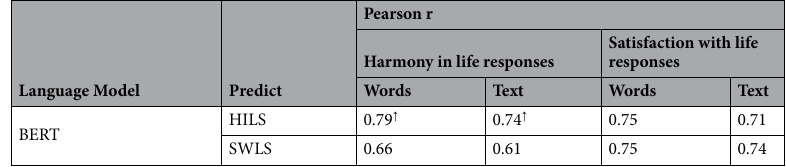
Table 3. The Construct Specific Validity of Language Models Using Individual Word- and Text-Responses. N = 608. HIL = Harmony in life; SWL = Satisfaction with life; S = Scale. ↓ = significantly higher than SWLS